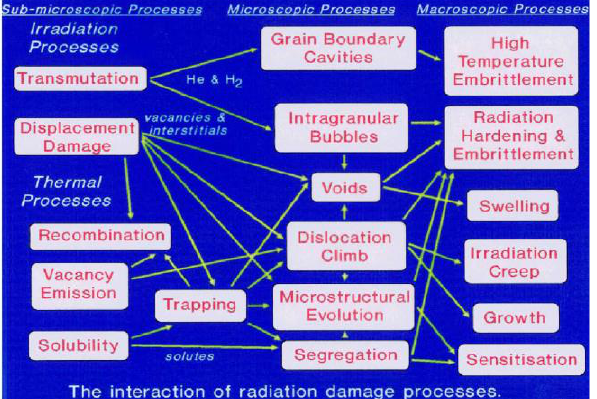
Figure 1. Main irradiation processes and primary neutronic effects with the consequent microscopic and macroscopic secondary responses of the irradiated materials [13].